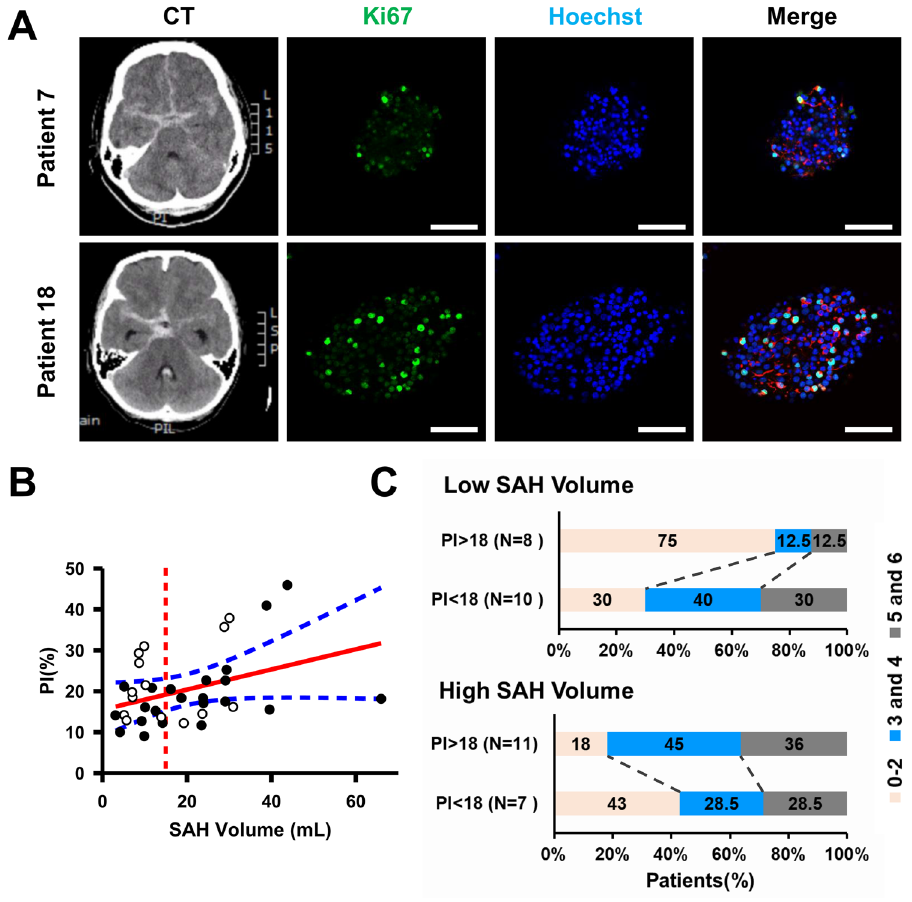
antibodies with Hoechst 33258 (blue) staining. Initial head CT scan shows SAH in two patients (Patients 7 and 18) with similar severity (SAH volume of 9.7 and 9.9 mL, respectively). The PI values in these two patients were 12.7 and 31.0, respectively; the mRS scores at post-SAH 3 months were 3 and 1, respectively. Scale bar = 50 μ m. ( B ) The outcome of SAH patients according to the SAH volume and PI. White spots indicate the patients with favorable outcome (mRS < 3) and black spots indicate poor outcome. The red solid line is the regression line, blue dashed lines are 95% confidence limits, and the red dashed line marks the SAH volume at 15 mL. N = 36. ( C ) The percentage of patients with mRS of 0-2, 3-4, and 5-6 at post-SAH 3 months according to PI values in low and high SAH volume groups. The low or high SAH volume is defined as the SAH volume at the subarachnoid cistern less or more than 15 mL,